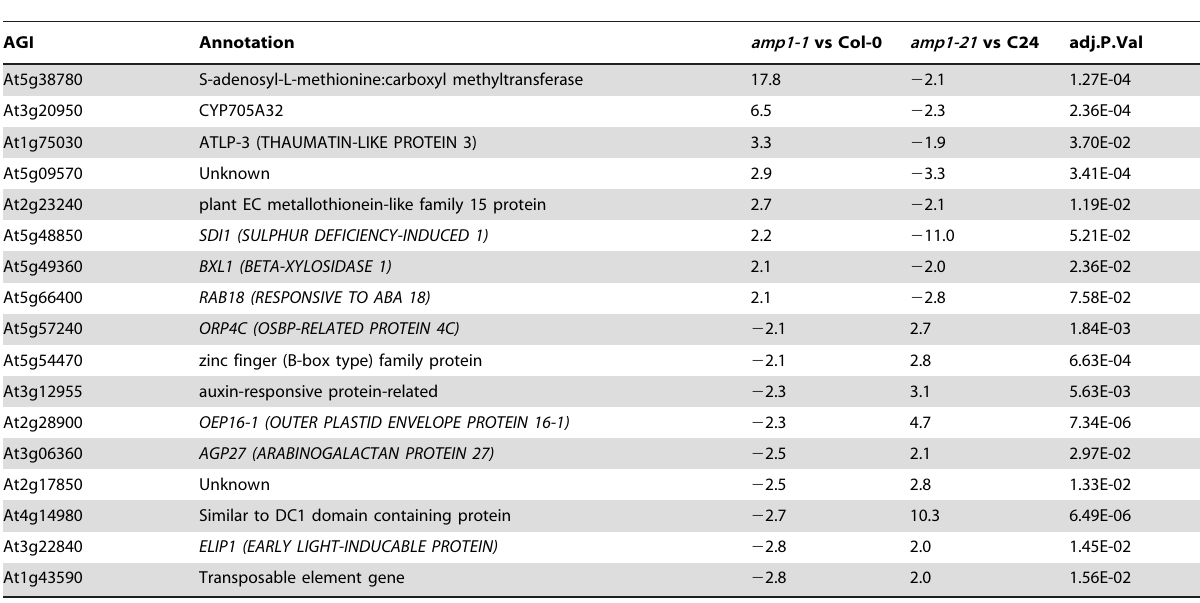
Table 2. Genes de-regulated in both mutants in opposing manners.